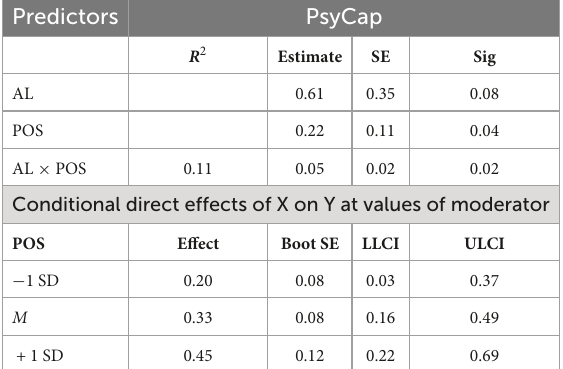
TABLE 5 Moderating role of